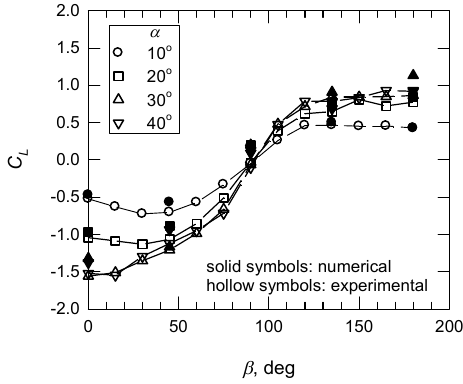
Figure 16. Uplift coefficient: numerical and experimental results.